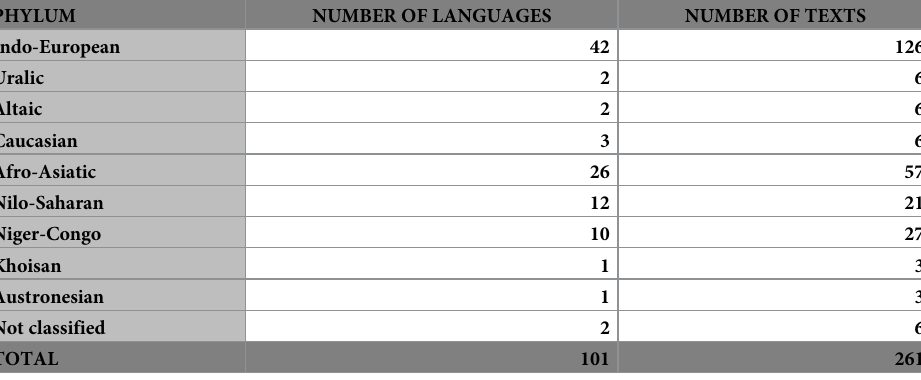
Table 1. Phyla, languages and texts considered and studied.